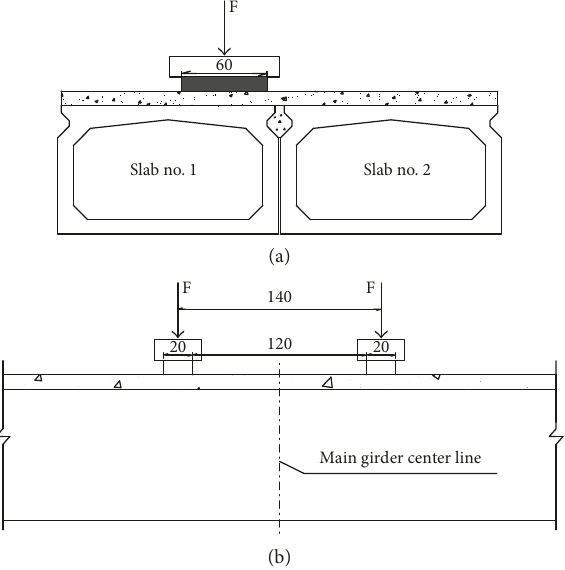
Figure 4: Hollow slab prototype test.